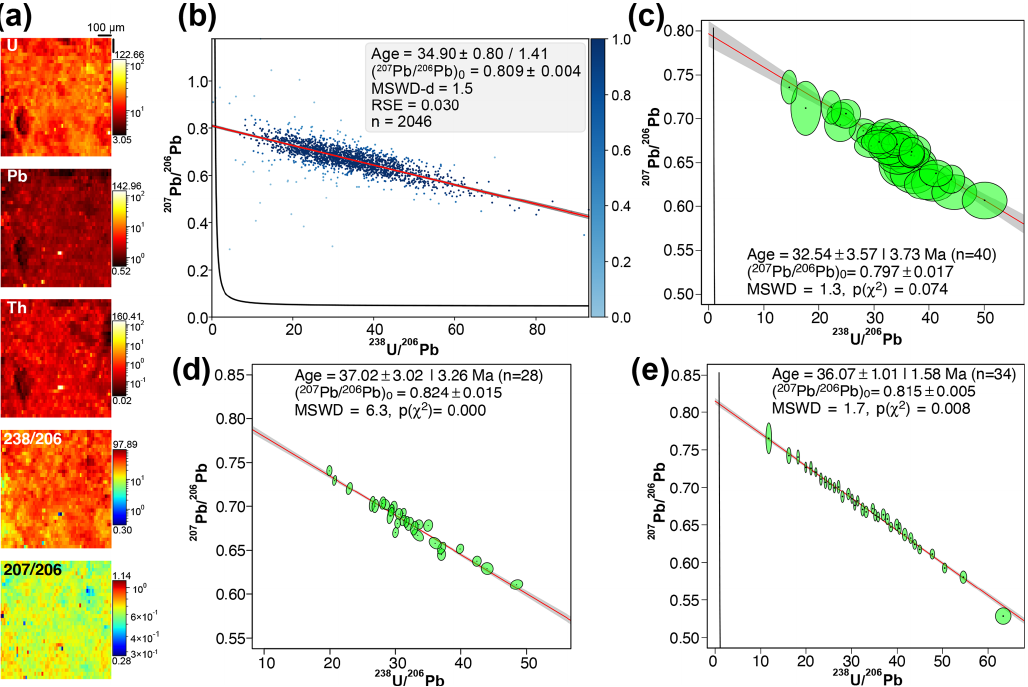
Figure 5. Results obtained for sample PGX32-2. (a) Semi-quantitative element concentrations in parts per million (U, Pb and Th) and 238 U / 206 Pb– 207 Pb / 206 Pb isotopic maps. (b) TW concordia plot calculated by robust regression. (c) TW concordia plot calculated from discretisation of the isotopic map (pseudo-spots). (d) TW concordia plot obtained from LA-ICP-MS spot analyses. (e) TW concordia plot obtained with the approach of Drost et al.